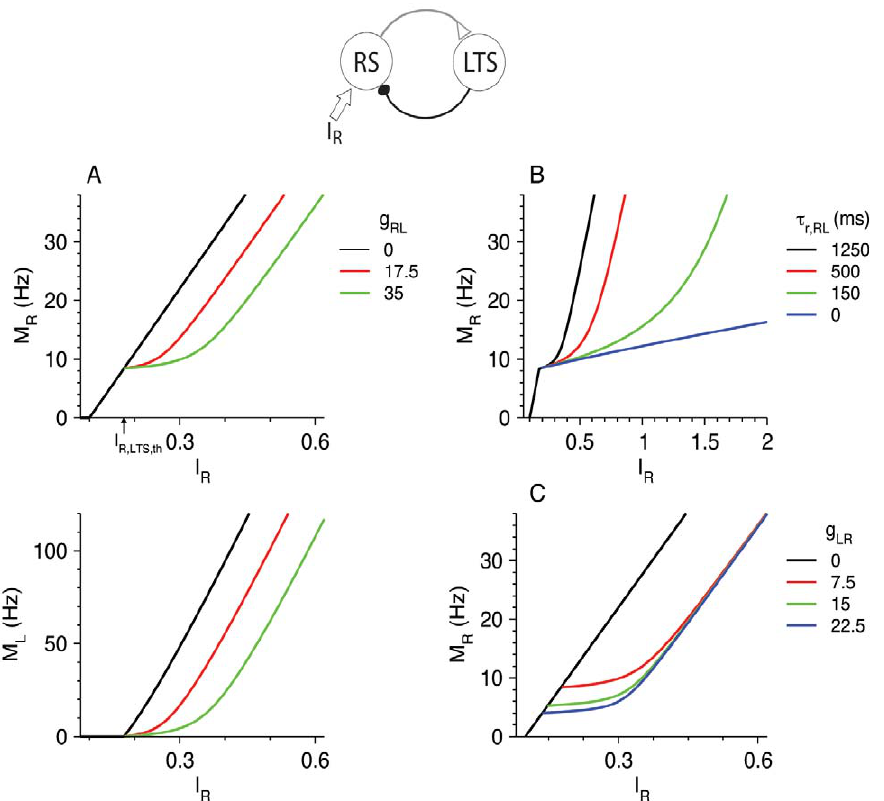
Figure 2. Steady-state response of the RS-LTS network with g RR =0 to constant inputs to the RS neurons. (A) M R - I R curves (top panel) and M L - I R curves (bottom panel) are plotted for g RL =0 (black), 17.5 (red) and 35 (green). Additional parameters are t r ,RL =1250 ms, g LR =7.5. The arrow below the abscissa in the top panel points to the value of I R,LTS,th . (B) M R - I R curves are plotted for t r ,RL =1250 ms (black), 500 ms (red) and 150 ms (green) and 0 (blue). Additional parameters are g RL =35, g LR =7.5. (C) M R - I R curves are plotted for g LR =0 (black), 7.5 (red), 15 (green) and 22.5 (blue). Additional parameters are g RL =35, t r ,RL =1250 ms.